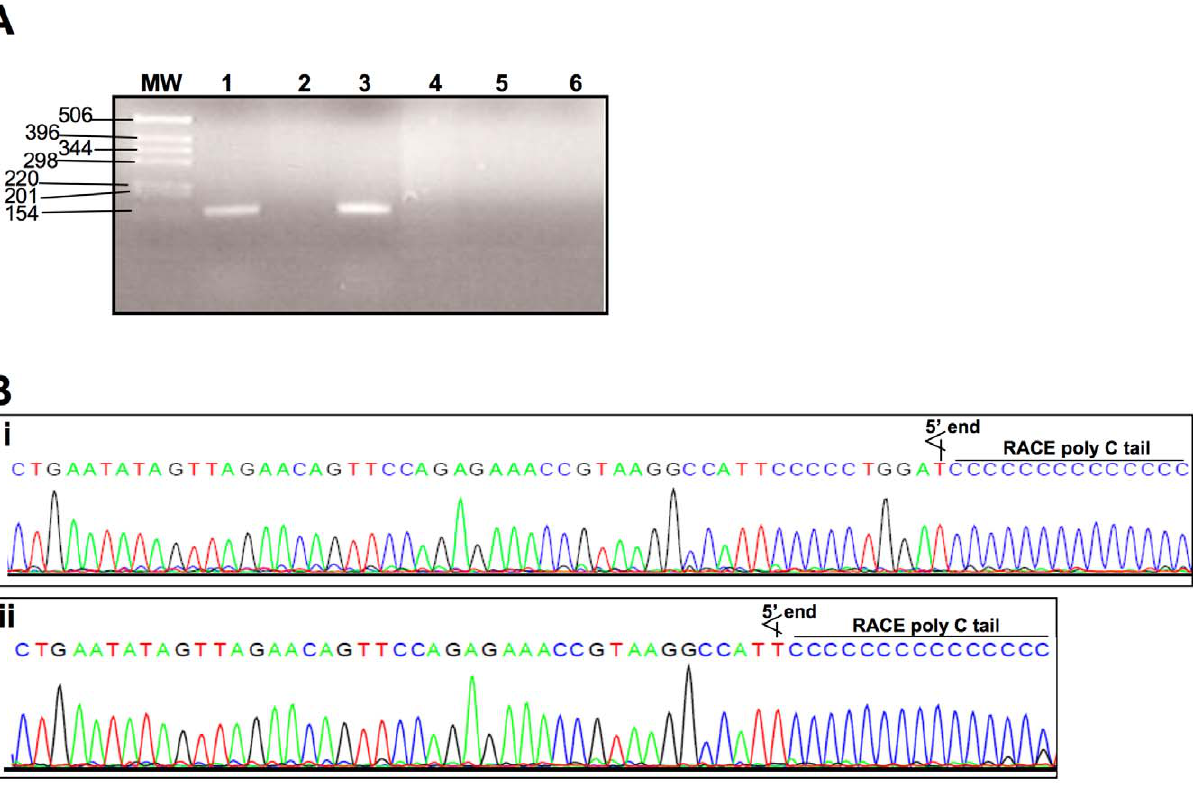
Figure 4. RT-PCR detection of sodC mRNA in B.neotomae and B.abortus RB51 (A) and identification of their 5 9 ends by RACE analysis (B). A) Total RNA extracted from the bacterial cultures at late log phase was used as template in RT-PCR or direct PCR for amplification of a 5 9 portion of sodC mRNA using a pair of specific primers. Post-amplification reaction mixtures of tubes containing RNA extracted from B. neotomae (lanes 1 and 2) or B. abortus RB51 (lanes 3 and 4) were separated on a 2% agarose gel by electrophoresis and stained with ethidium bromide to visualize the DNA fragments. Lanes 1 and 3, RT-PCR reaction mixtures. Lanes 2 and 4, PCR reaction mixtures. Lanes 5 and 6, reaction mixtures from no-template-controls of RT-PCR and PCR reactions, respectively. Lane marked MW contains DNA molecular size marker, and the numbers at the left indicate molecular size in base-pairs. B) Representative nucleotide sequencing chromatograms showing the location of 5 9 ends of the cloned sodC cDNAs from B. abortus RB51 (i & ii) and B. neotomae (ii).